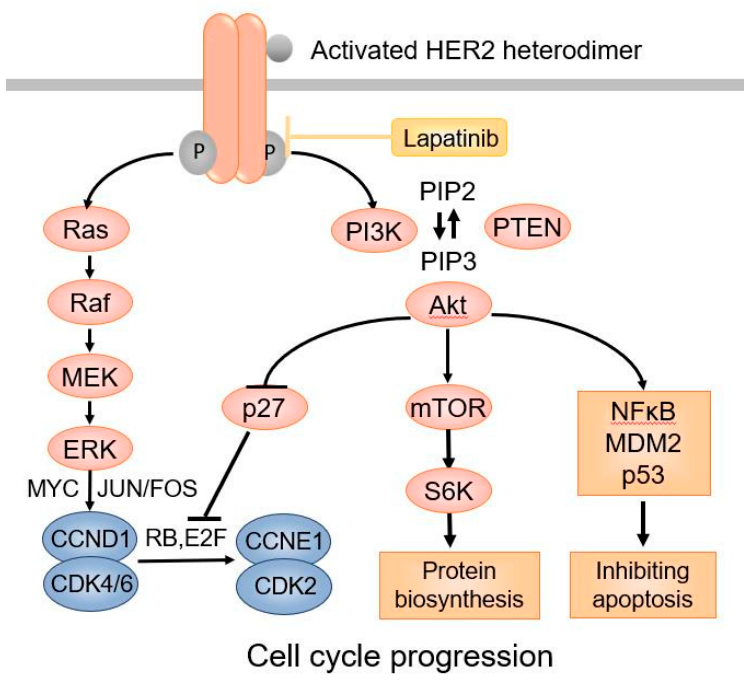
Figure 1. The HER2 signaling pathway.